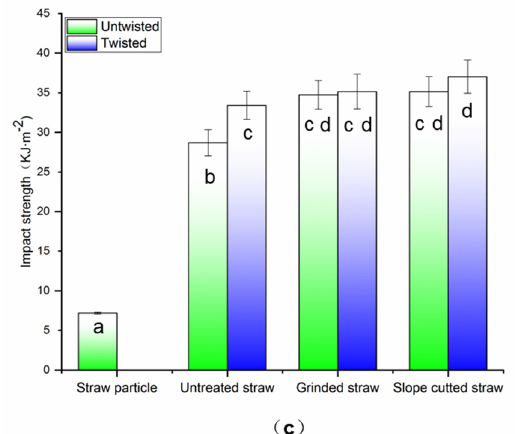
Figure 4. Mechanical properties of straw/LLDPE composites with different shapes (the same letters at the top of the bar chart indicate no significant difference): tensile property ( a ), flexural property ( b ), and impact strength ( c ).